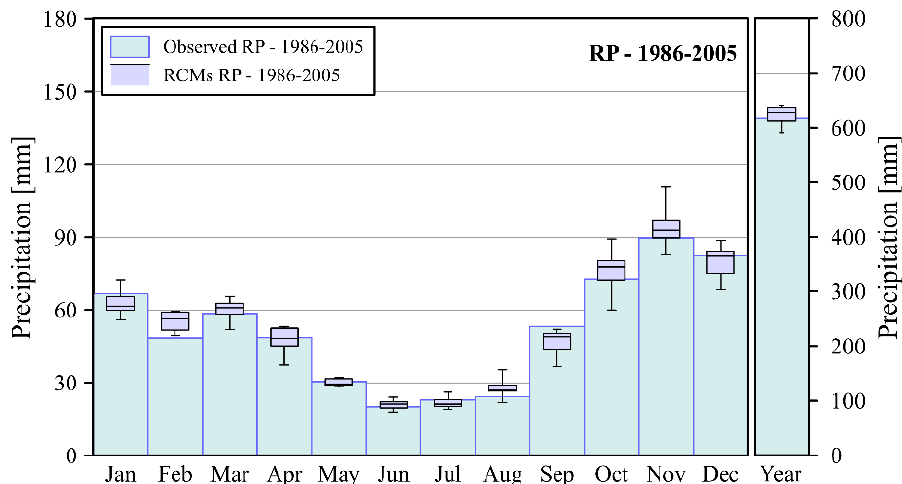
Figure 6. Monthly and annual precipitation over the Salento area, observed and evaluated by the RCMs in the reference period (RP). The box-whisker plots represent the variability between the 13 RCMs (the whiskers indicate the minimum and maximum values).